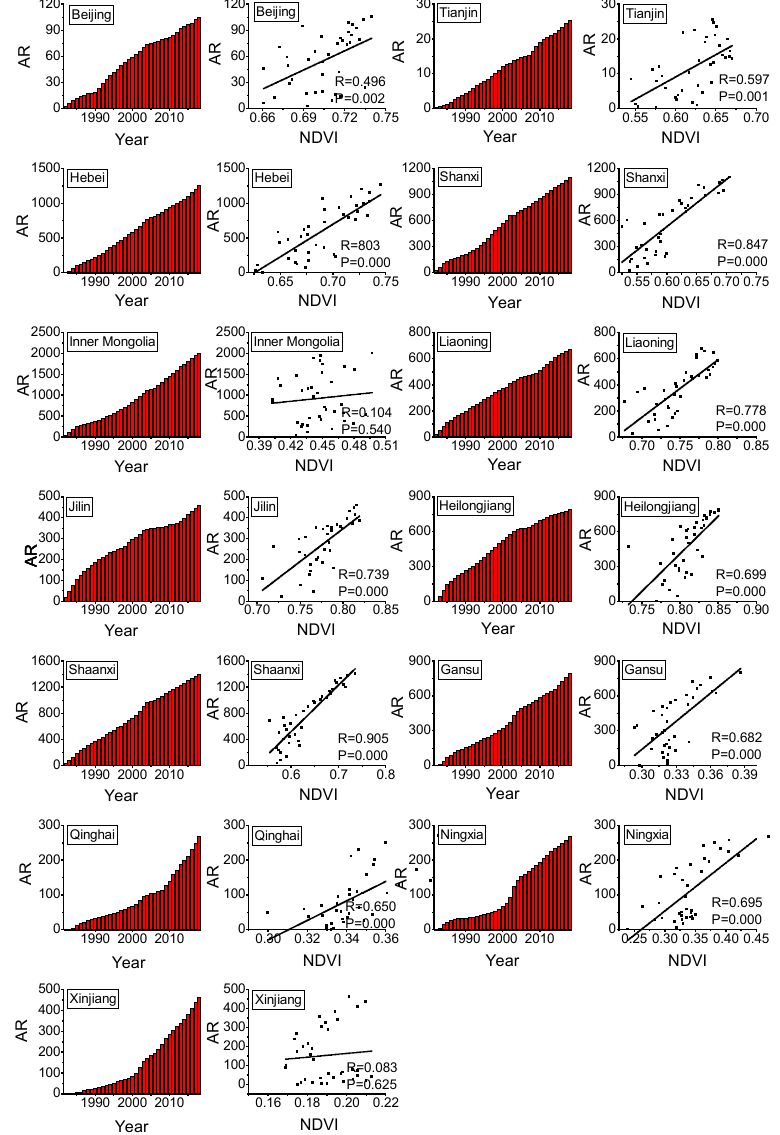
Figure 12. Accumulated reforestation area for different provinces in northern China and its relationship with regional average NDVI from 1982 to 2018 (AR represents the accumulated reforestation area, and the unit is 100 km 2 ; NDVI represents the regional average NDVI for provinces; R is the correlation coefficient; P presents the significance of the linear